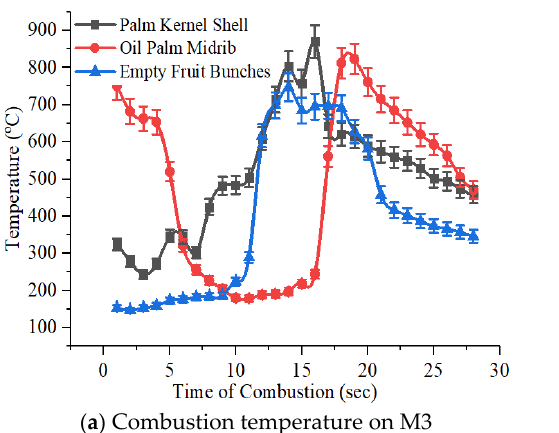
Figure 7. Residual ashes after the burning process. Further analysis was conducted in this study at the M4 point with the same time and fuel from the previous analysis. Measurements at the M4 are performed to determine the maximum heat temperature level when reaching the boiler. Based on the results of the analysis, the OPM fuel was slightly higher at 757 °C, recorded at 19 s, while the maximum heat temperature of the PKS and EFB reached 729 °C and 692 °C, respectively, as shown in Figure 8a. The heat temperature phenomenon of the three types of fuel used shows better results as shown in Figure 8b. ( a ) Combustion temperature on M4. ( b ) 3D temperature display on M4. Figure 8. Temperature measurement at M4 with different fuels.